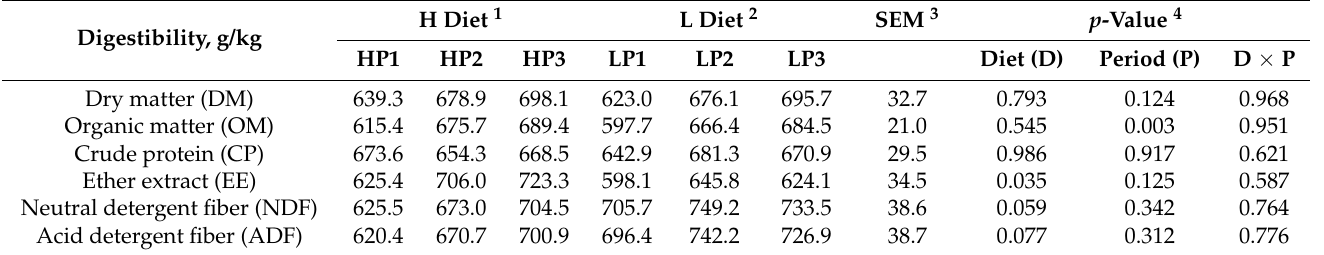
Table 2. Nutrient apparent digestibility over three collection periods in high- and low-density